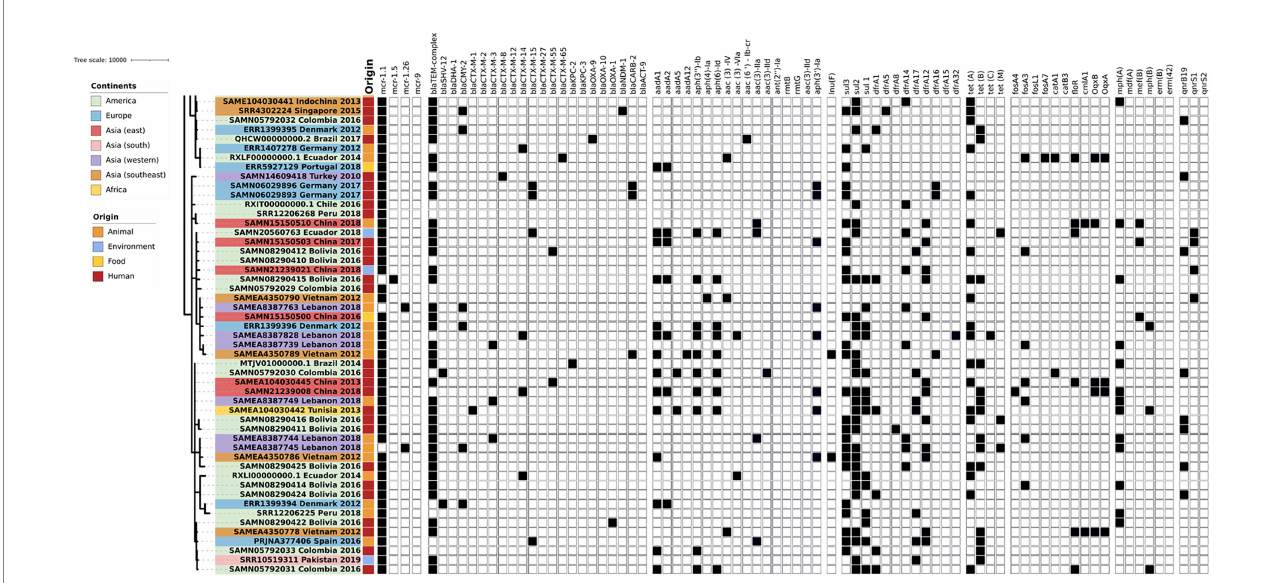
FIGURE 5 Antibiotic resistance genes content of the evaluated E. coli sequences (Part two). The source of the isolates is specified by different colors in the genomic cg-MLST tree branches. Squares indicate the presence (black) and absence (white) of antibiotic resistance